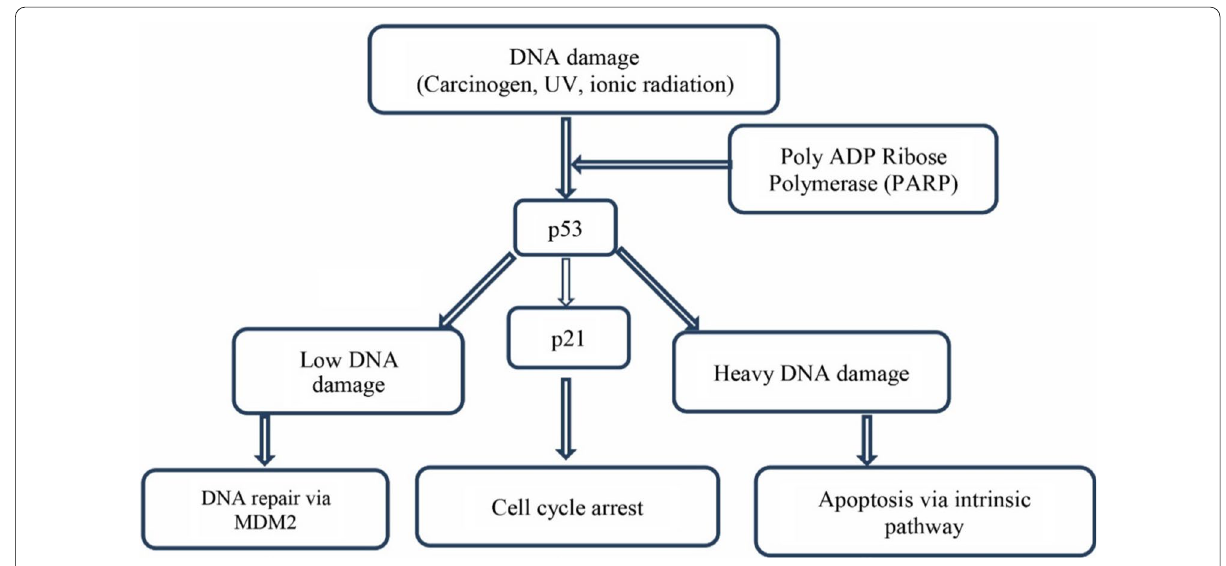
Fig. 1 Role of P53 in maintaining genomic